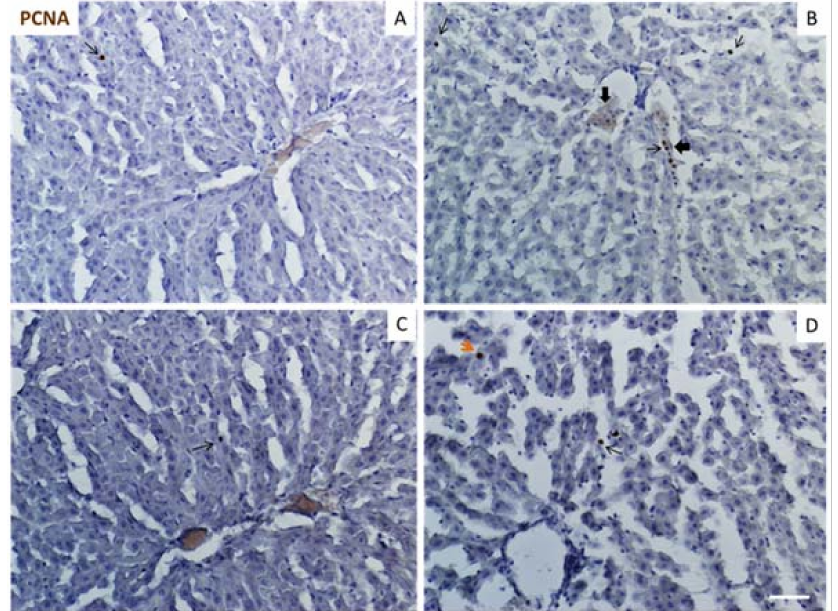
Figure 7. Expression of proliferating cell nuclear antigen (PCNA) in liver tissue from Control and MS rats. Thin arrows indicate the locations of PCNA positive cells. The thick arrows indicate cellular infiltrates and the orange arrow indicates a PCNA positive hepatocyte. Panel ( A ) = Control group, Panel ( B ) = metabolic syndrome (MS) group, Panel ( C ) = control/RSV + QRC group, Panel ( D ) = MS/RSV + QRC group. Bar = 100 µ